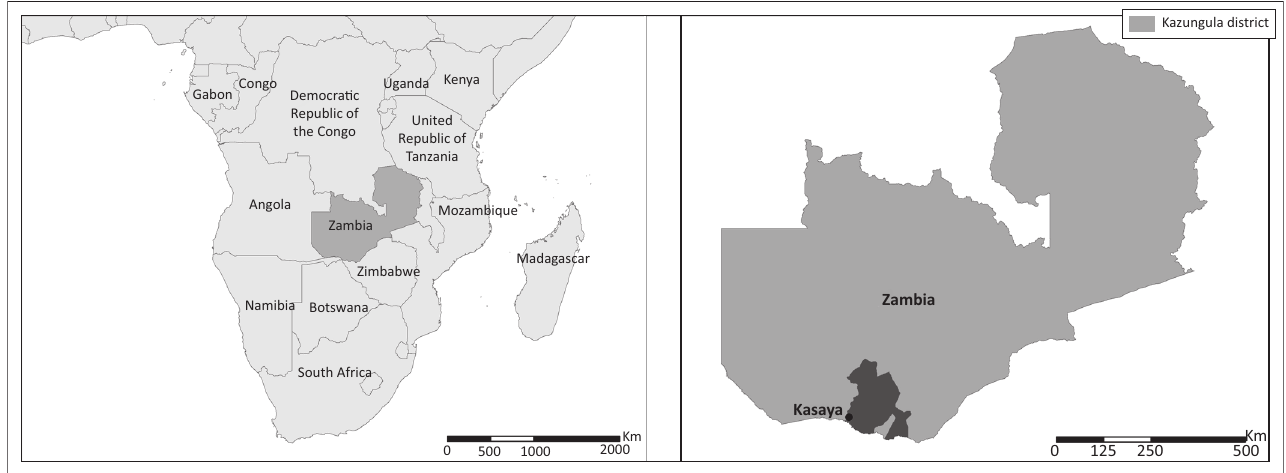
FIGURE 2: Locator map of Kasaya, in the Kazungula District of Zambia’s Southern